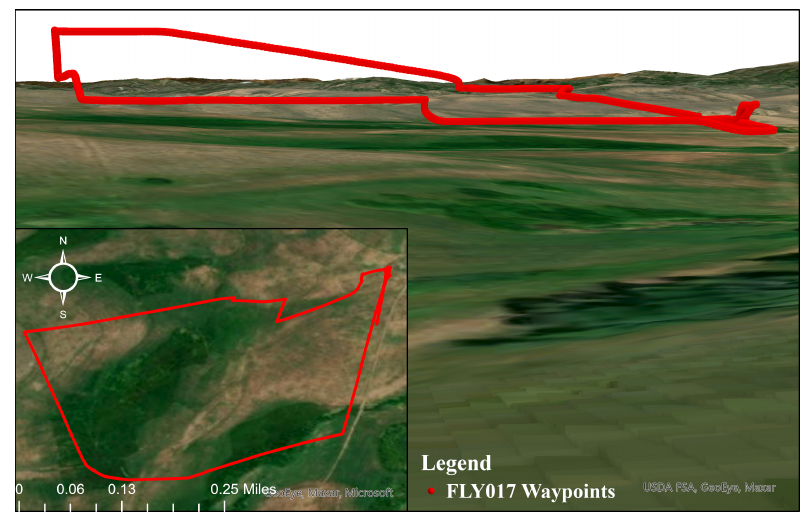
Figure 8. 2D and 3D representation of the flight log using ArcGIS Pro.